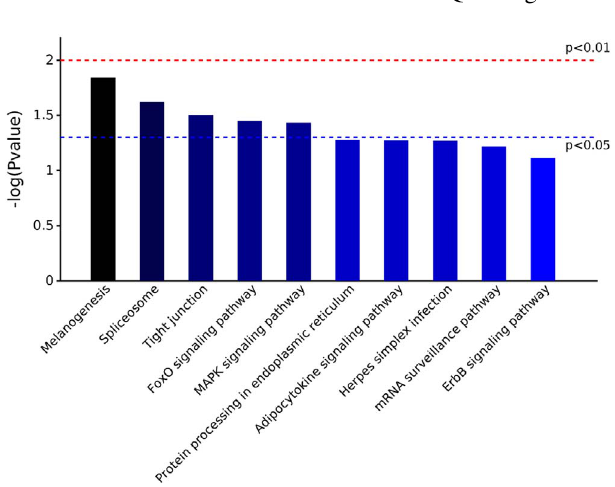
Figure 6. KEGG pathway classi fi cation of differentially expressed proteins in DF-1 cells transiently transfected with